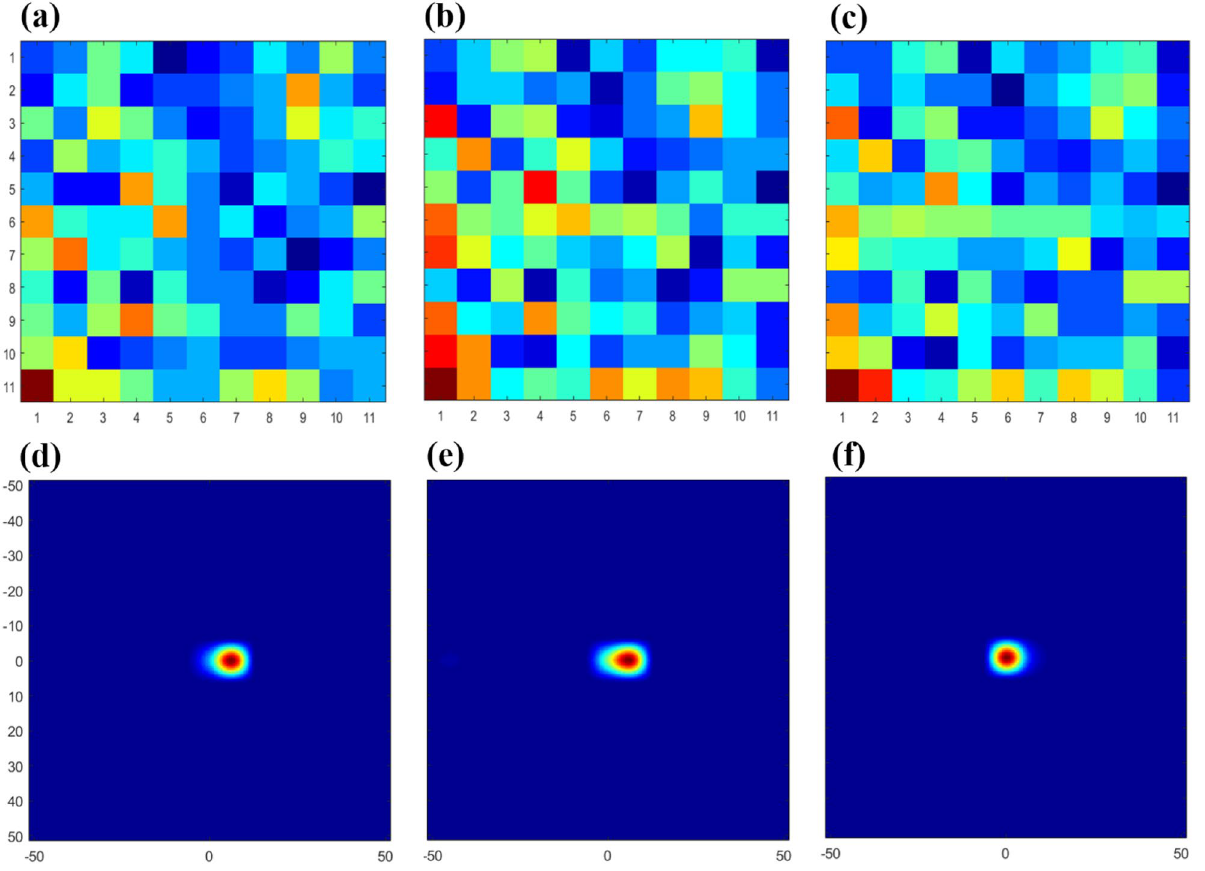
Figure 7. Comparison of reconstructed images of neutron when exposed to a 3.5 × 10 5 n/s 252 Cf spontaneous fission source at 100 cm distance. Detector map composes of the neutron events obtained for 1 min (330 events) ( a ), 3 min (1,000 events) ( b ), and 6 min (2,000 events) ( c ). The three detector maps correspond to the images reconstructed by using MLEM ( d–f ), respectively. Number of neutron events above 200